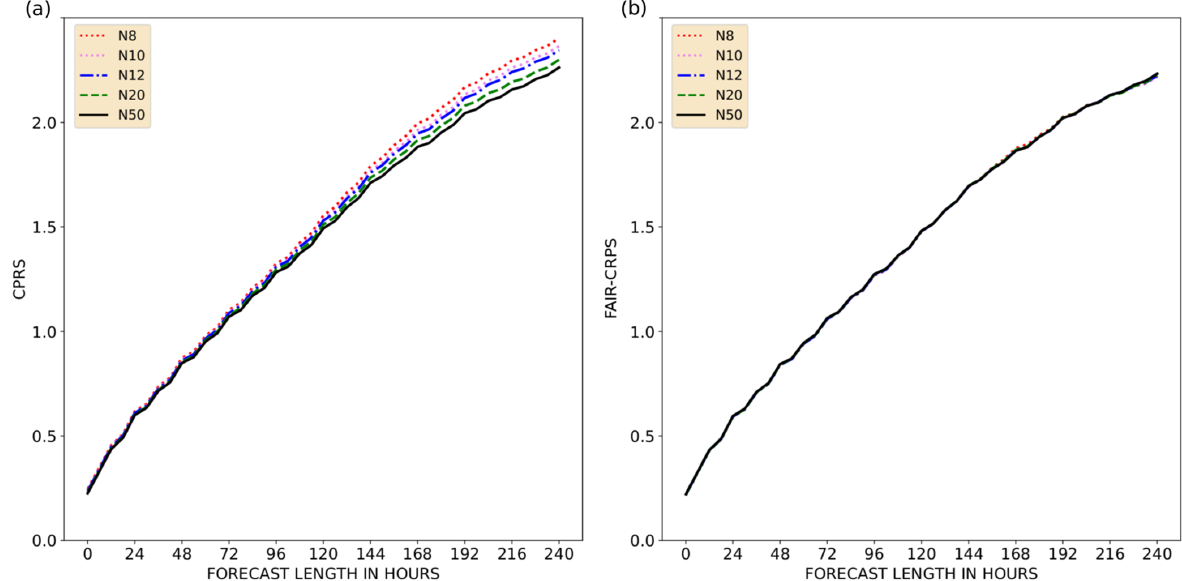
Figure 3. CPRS (a) and fair CRPS (b) of temperature at 850hPa as a function of forecast lead time, up to 240h. The mean is calculated over 46 start dates. Both panels show the T L 159-resolution scores for the Northern Hemisphere, with different colours and line styles representing the various ensemble sizes used to calculate the scores: 50 (continuous black), 20 (dashed green), 12 (dot-dashed blue), 10 (dotted pink), and 8 (dotted